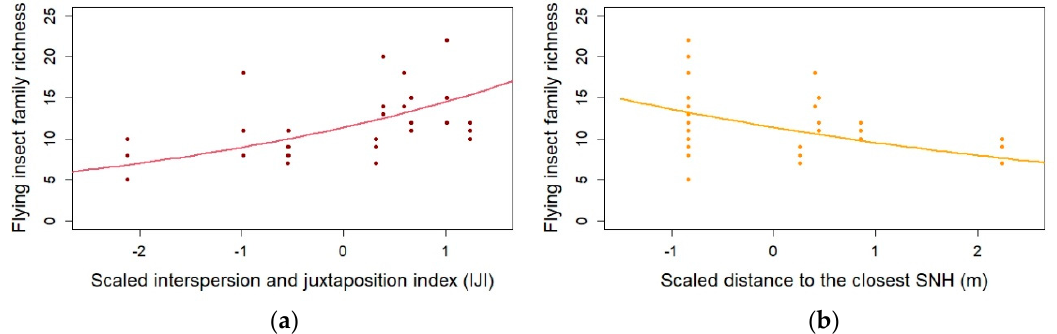
Figure 3. ( a ) Flying insect family richness variations according to the interspersion and juxtaposition index IJI (red; E = 0.2419, p -value < 0.001), and ( b ) distance to semi-natural habitat SNH (yellow; E = 0.0798, p -value < 0.01)—Glmer with Poisson family; N = 30.